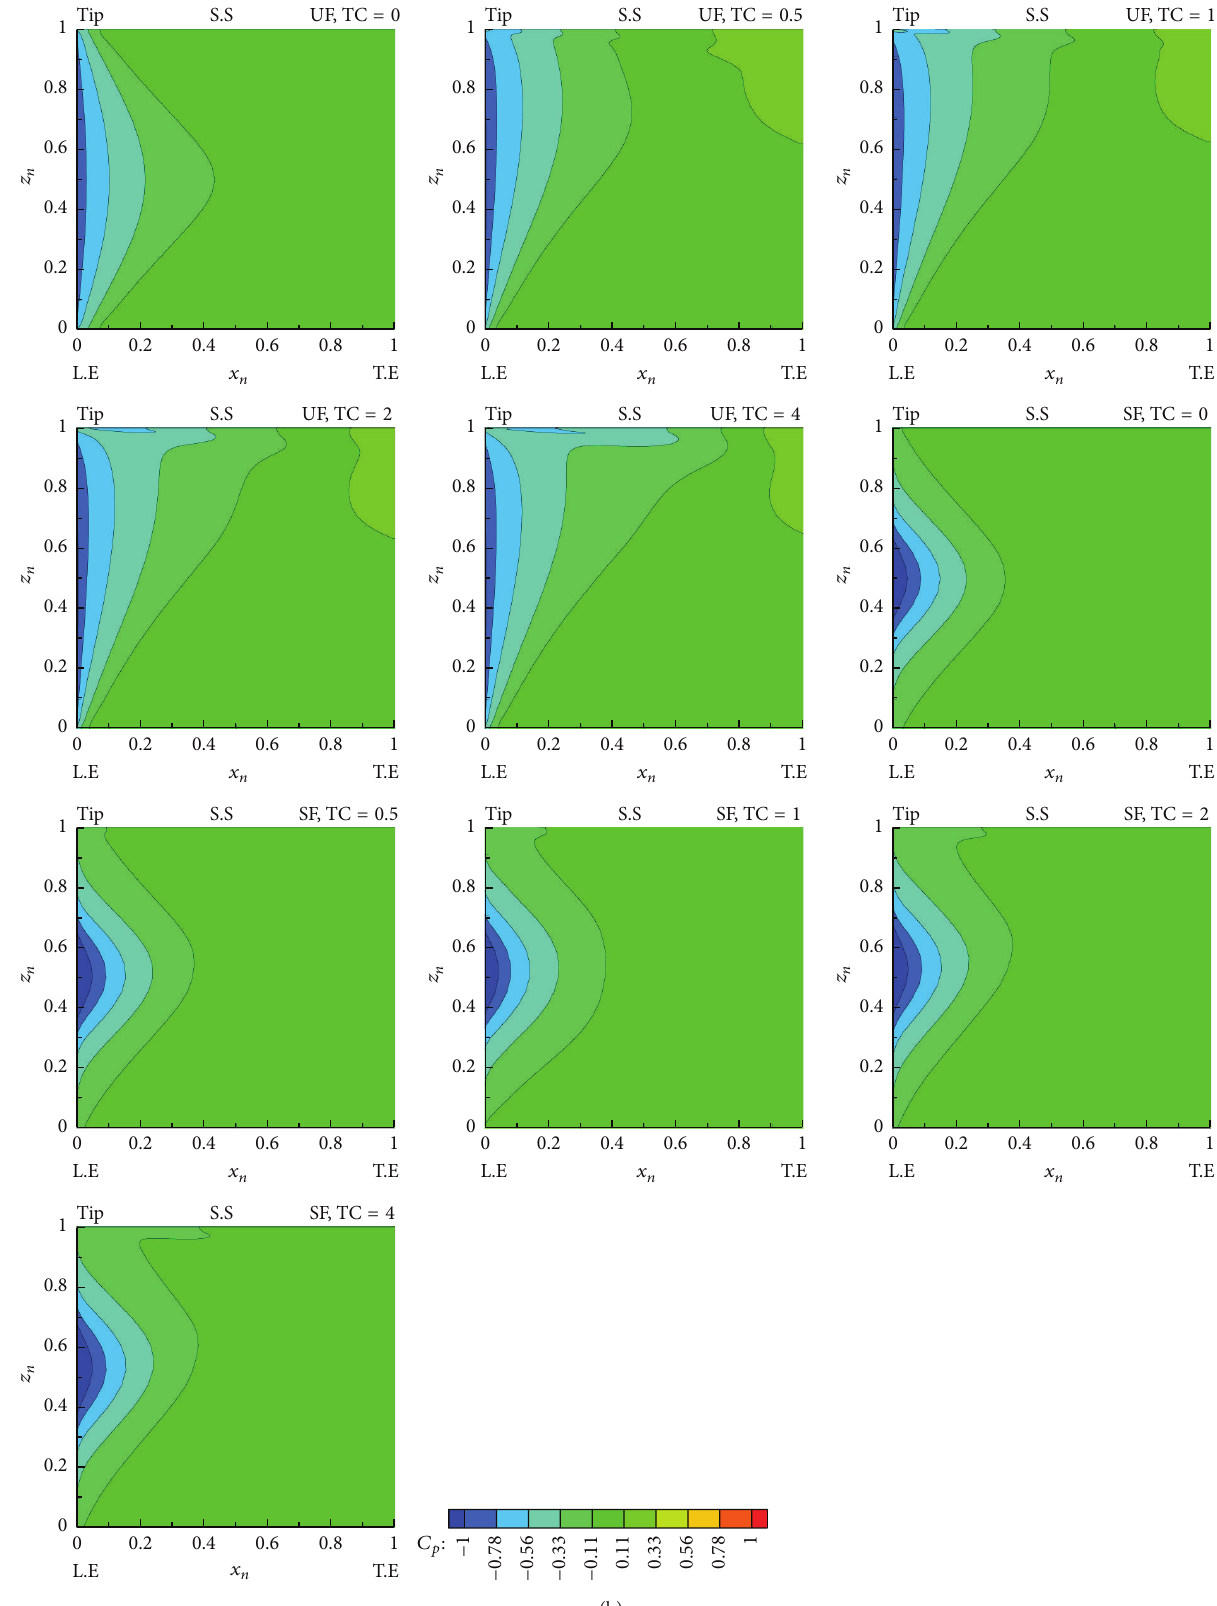
Figure 7: (a) 𝐶 𝑝 contours on the pressure surface of the blade with UF and SF for TC = 0 to 4, (b) 𝐶 𝑝 contours on the suction surface of the blade with UF and SF for TC = 0 to